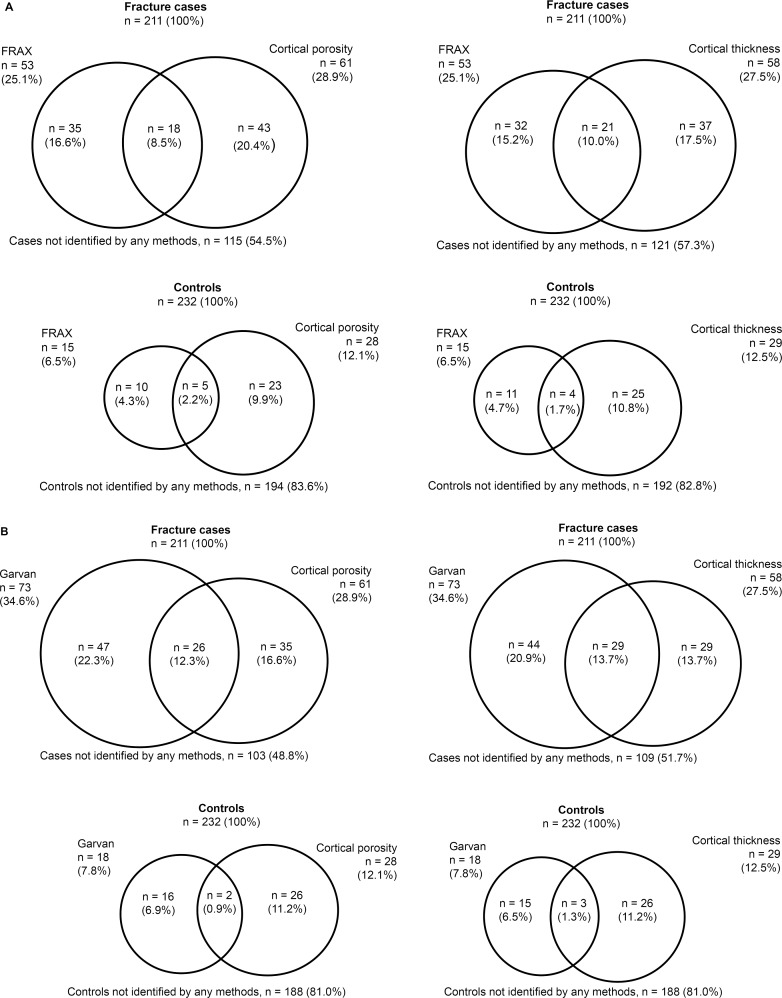
Venn diagrams show the number and proportion of woman identified using threshold for (A) Fracture Risk Assessment Tool (FRAX) estimate >20%, cortical porosity >80th percentile, and cortical thickness <20th percentile, and (B) Garvan estimate >25%, cortical porosity >80th percentile, and cortical thickness <20th percentile.